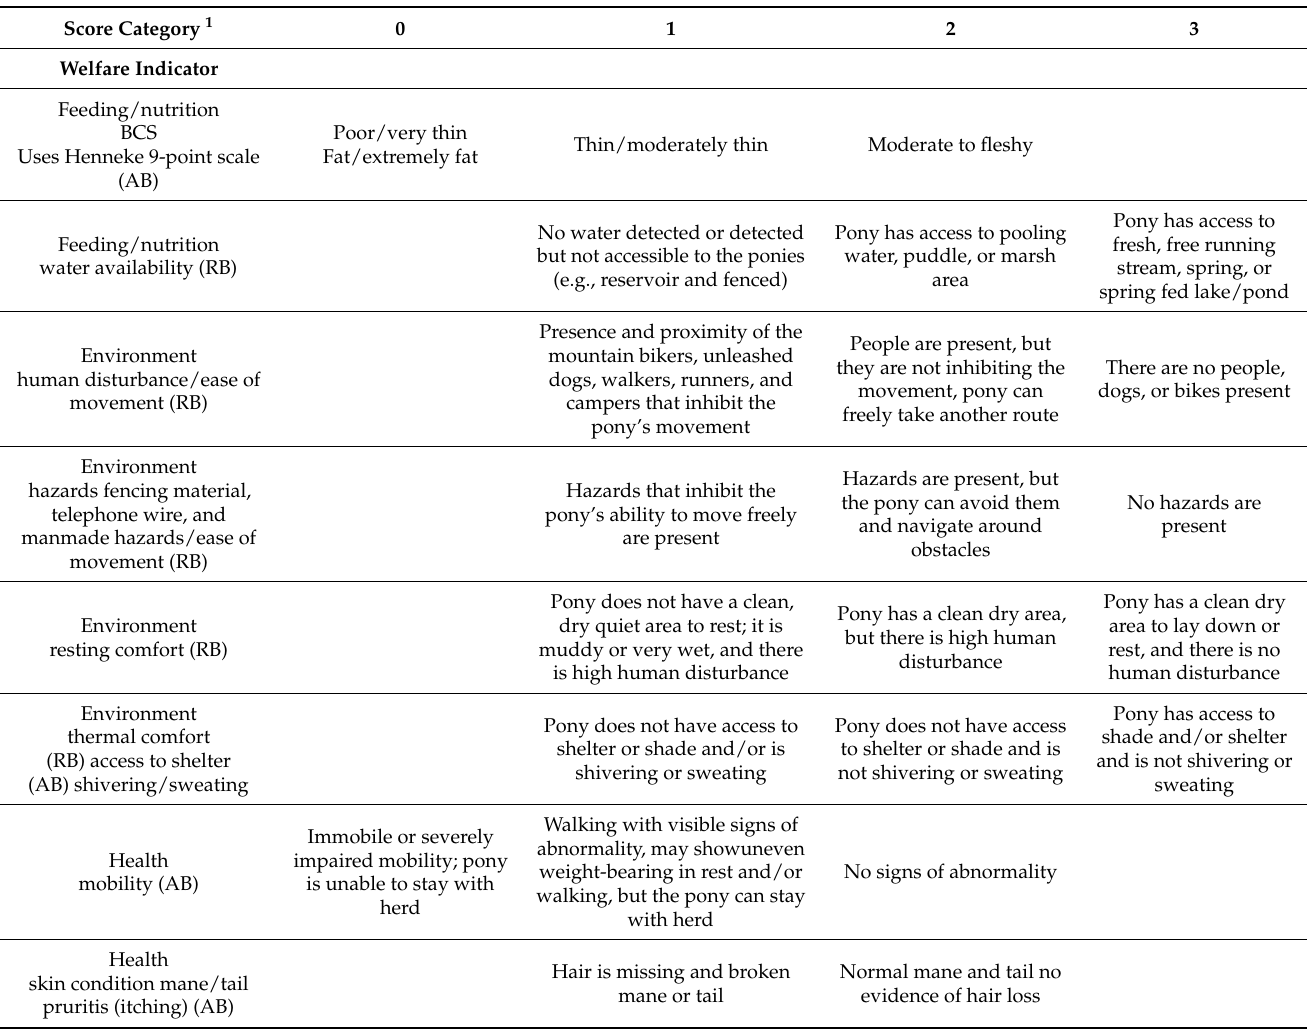
Table 1. List of the animal-based (AB) and resource-based (RB) welfare indicators chosen with details of possible outcomes for each assessed pony. The use of the HGS was only indicated as a second level assessment if a score of zero had been assigned for another